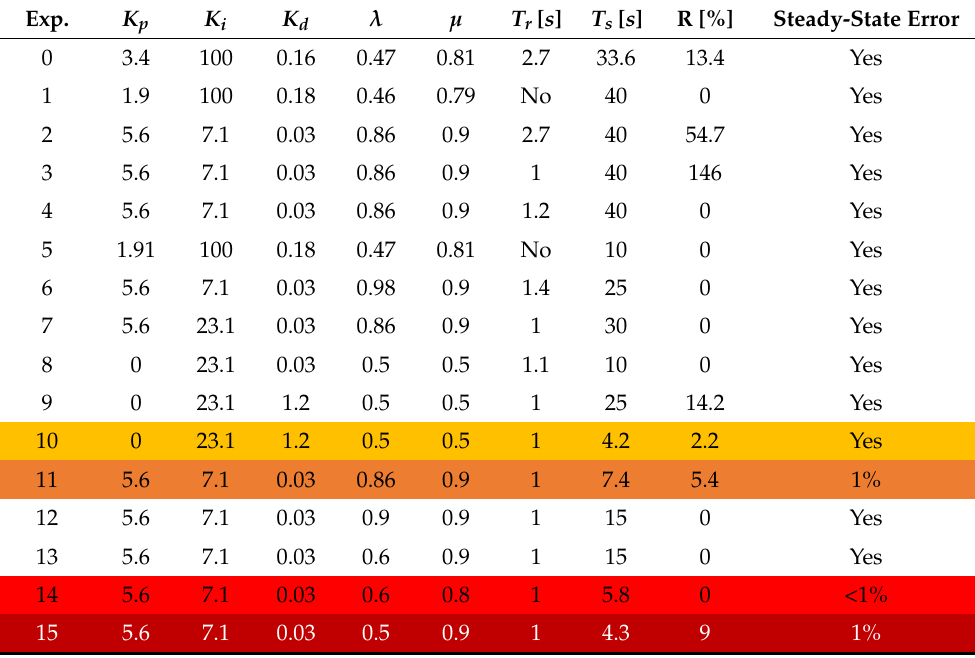
Table 4. Step responses of a real DEA using PI λ D µ with different parameters, part